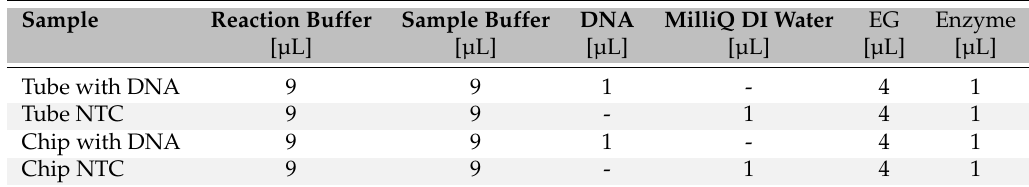
Table A3. On-chip MDA reaction mixtures.